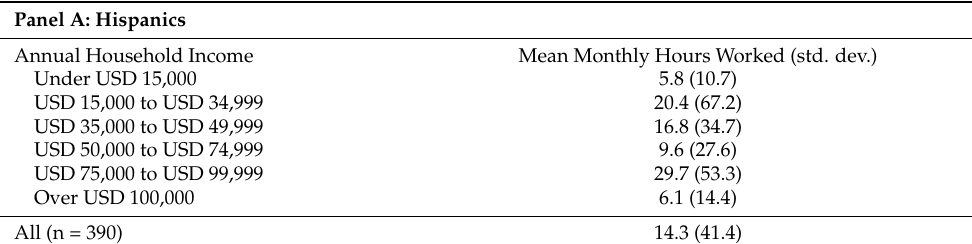
Table 6. EIWA and Hours Worked Usually Spent on Paid Work Activities or Side Jobs, Other than Primary Job for Hispanics and Other Racial/Ethnic Groups Over Last 6